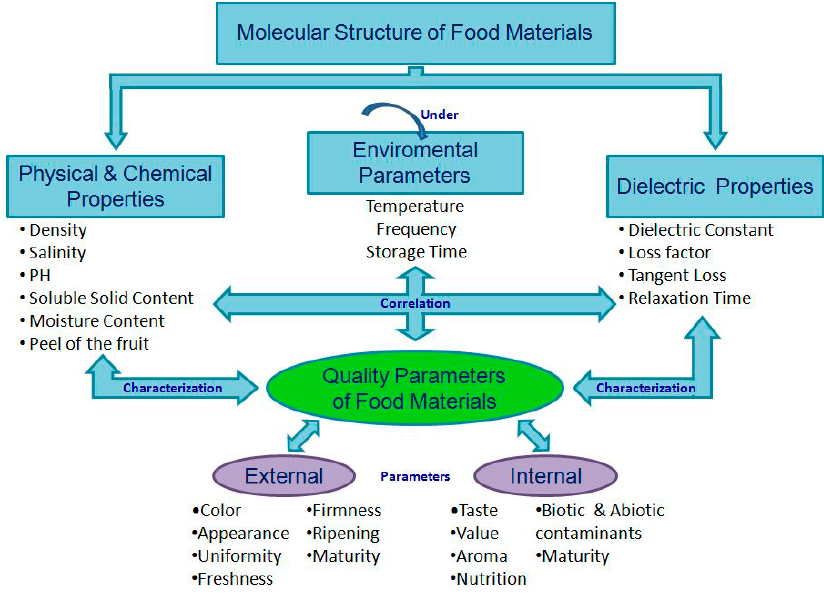
Figure 3. Correlation between dielectric properties and physical/chemical properties .